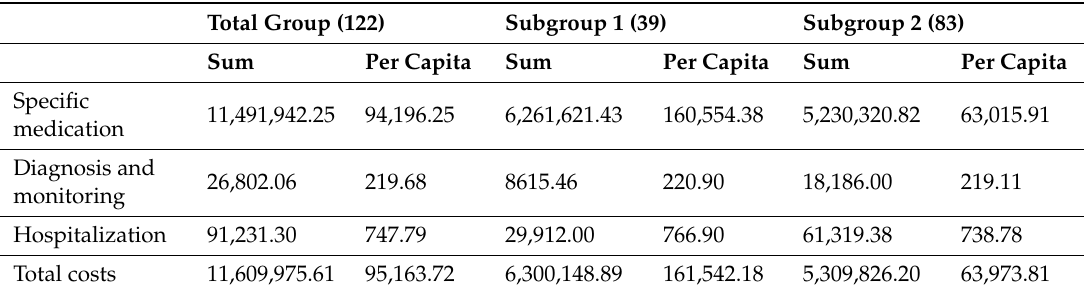
Table 5. Distribution of the BW-adjusted direct costs / patient / year (EUR).